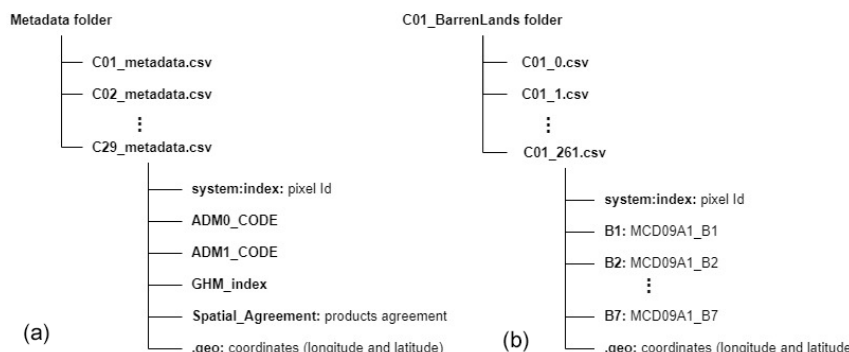
Figure 8. Data structure of the metadata folder (a) and the time series data folder (b) for the class “barren lands” in the original